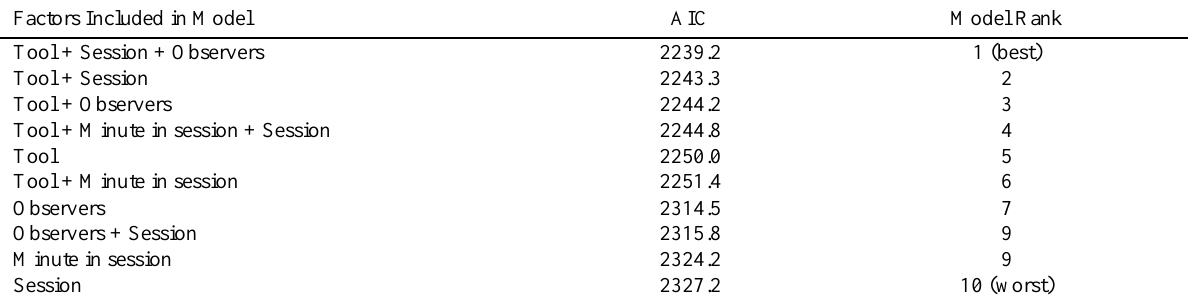
Mixed Effects Logistic Regression Models and Associated AIC Values, for the Models Predicting Sampling the Tool Factors Included in Model AIC